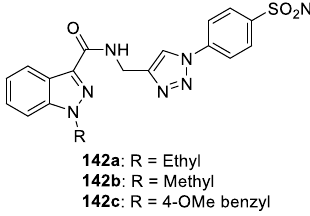
Figure 37. Chemical structures of indazole-3-carboxamide derivatives 142a – c .